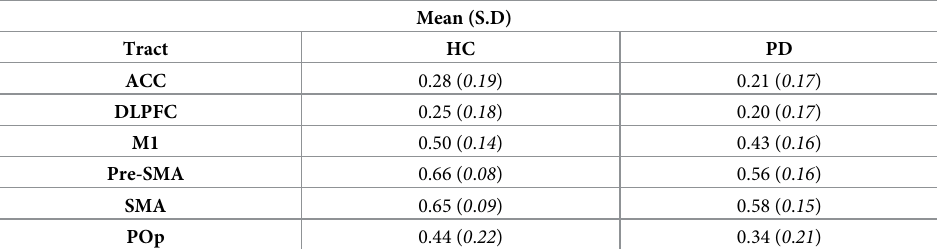
The means and standard deviations (S.D) of tract strengths for tracts running between the subthalamic nucleus (STN) and the pars opercularis (POp), anterior cingulate cortex (ACC), dorsolateral prefrontal cortex (DLPFC), primary motor cortex (M1), presupplementary motor area (pre-SMA) and supplementary motor area (SMA), for Parkinson’s disease subjects (PD) and healthy controls